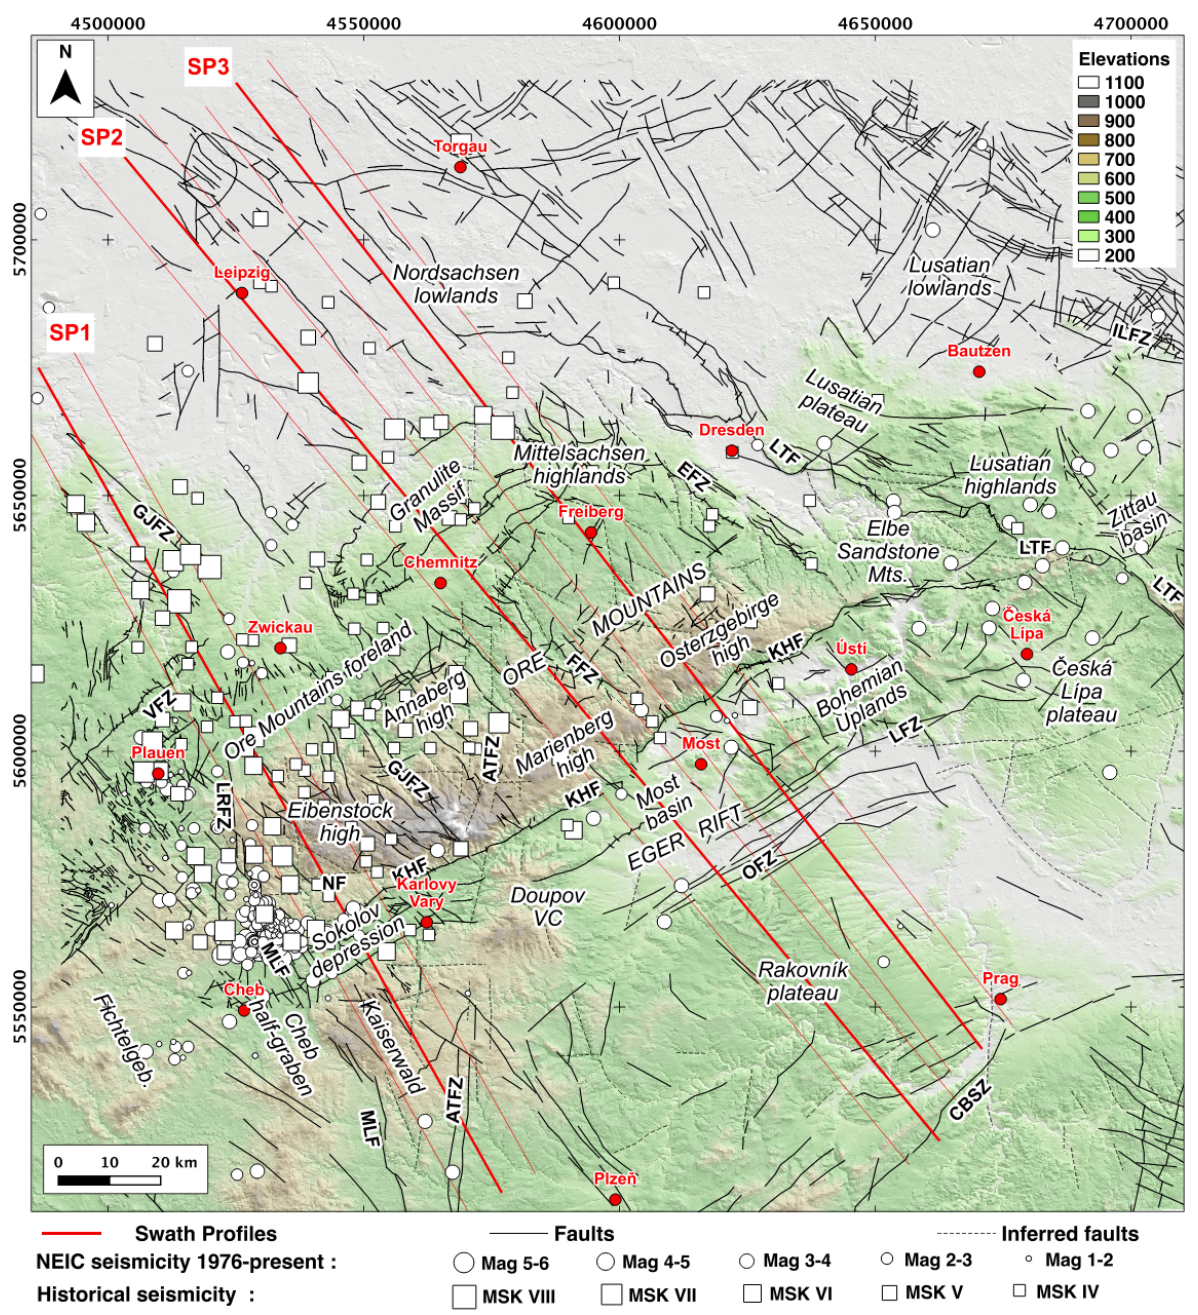
Figure 3. Seismicity of the Eger Rift and Ore Mountains regions